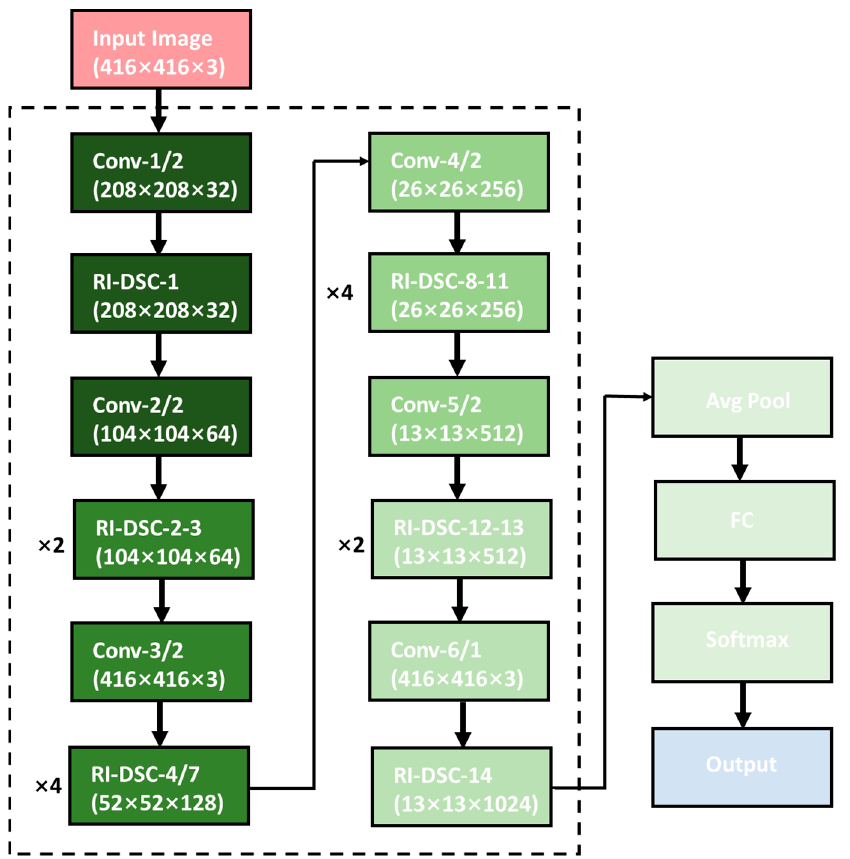
Figure 5. UW_YOLOv3 network structure diagram. The shape of the output feature graph of the layer is in parentheses for each module. Table 2. Comparison of quantitative results of underwater image enhancement.